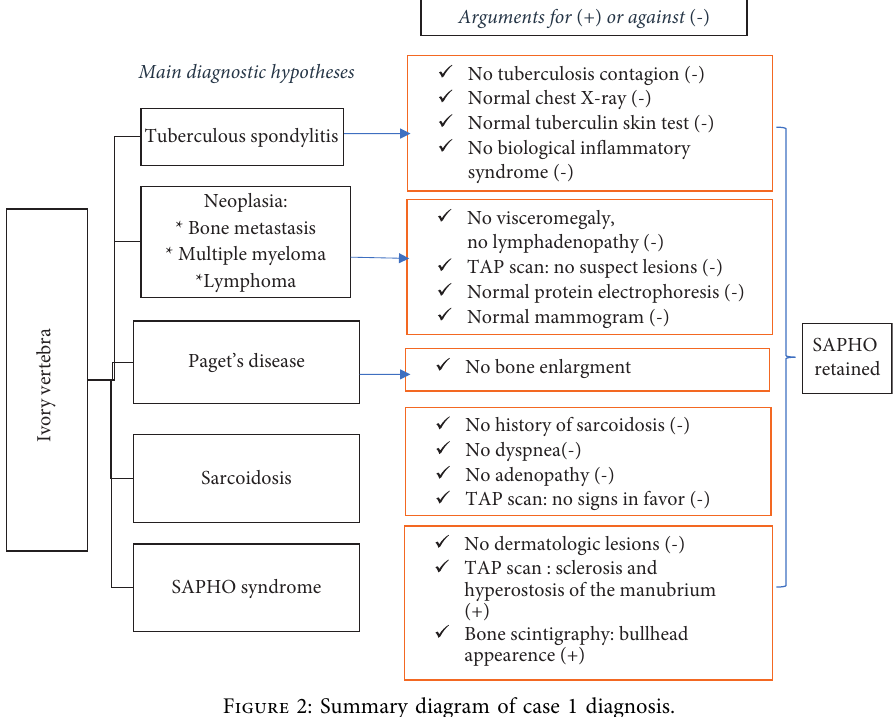
Figure 2: Summary diagram of case 1 diagnosis.